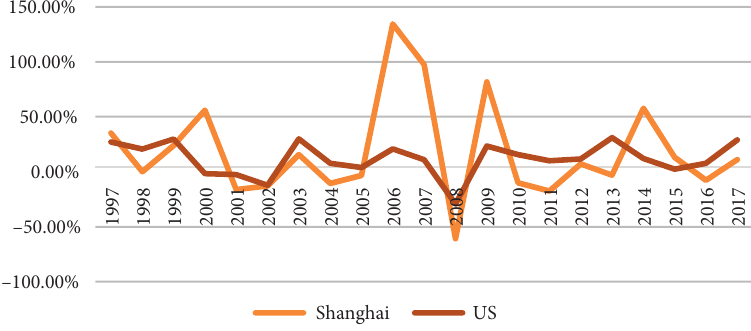
Figure 2. Stock market’s